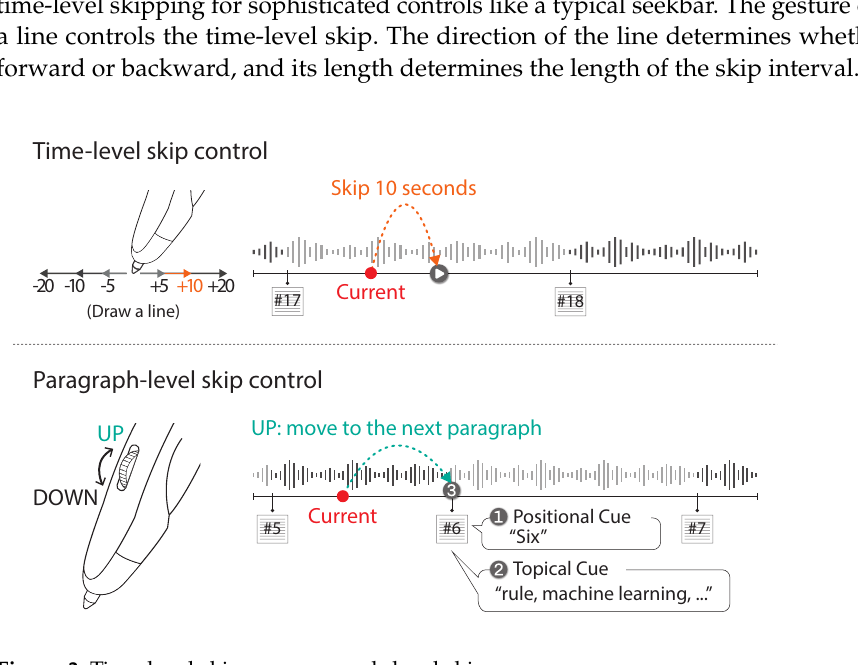
Figure 3. Time-level skip vs. paragraph-level